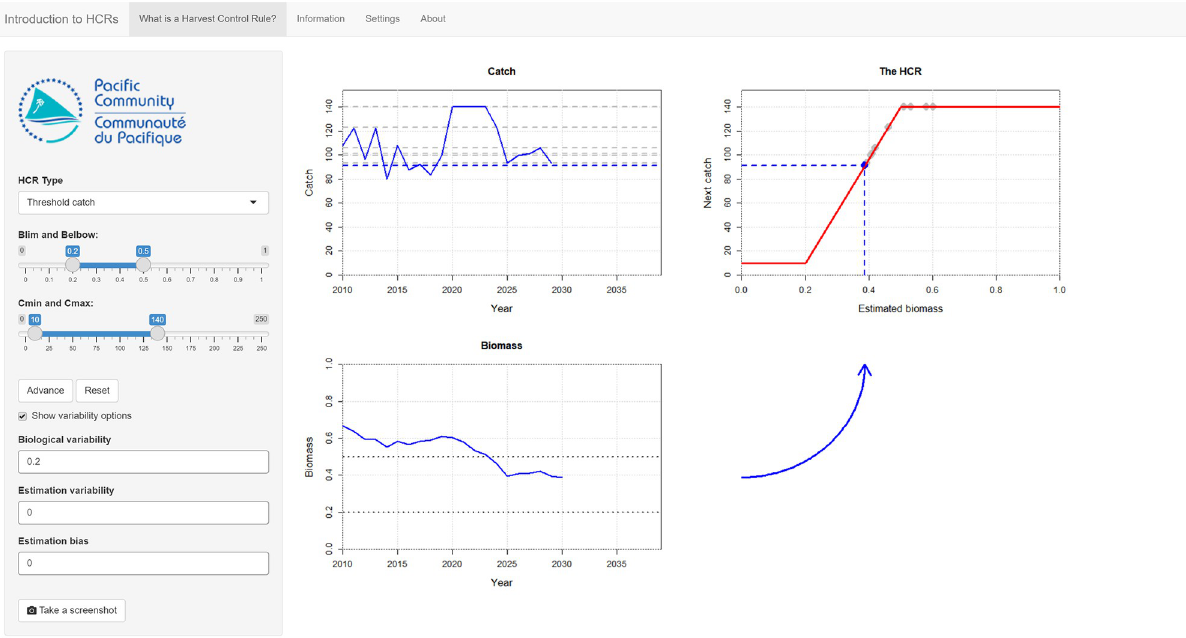
Fig 2. A screenshot of the main page of the Introduction to HCRs app. The controls that set the shape of the HCR and the variability options are in the left-hand panel. Biological variability has been switched on to include uncertainty in the result. In this example, the Advance button has already been pressed several times to project forward several years. The estimated stock biomass (the bottom left plot) is used by the HCR (the top right plot) to set the catch limit in the next year (the top left plot). The blue vertical dashed line on the HCR plot is the current estimated stock biomass. The blue arrow connects the biomass plot to the HCR. The shape and position of the arrow changes as the current estimated biomass changes to reflect how the input to the HCR changes. The catch limit in the next year is shown as the blue dashed horizontal line in the HCR and catch plots. Previous values are shown as grey dots on the HCR plot and grey dashed lines in the catch plot. The biomass plot shows the Limit Reference Point (LRP) and Target Reference Point (TRP) as dashed horizontal lines. https://doi.org/10.1371/journal.pone.0269543.g002 PLOS ONE | https://doi.org/10.1371/journal.pone.0269543 June 8,